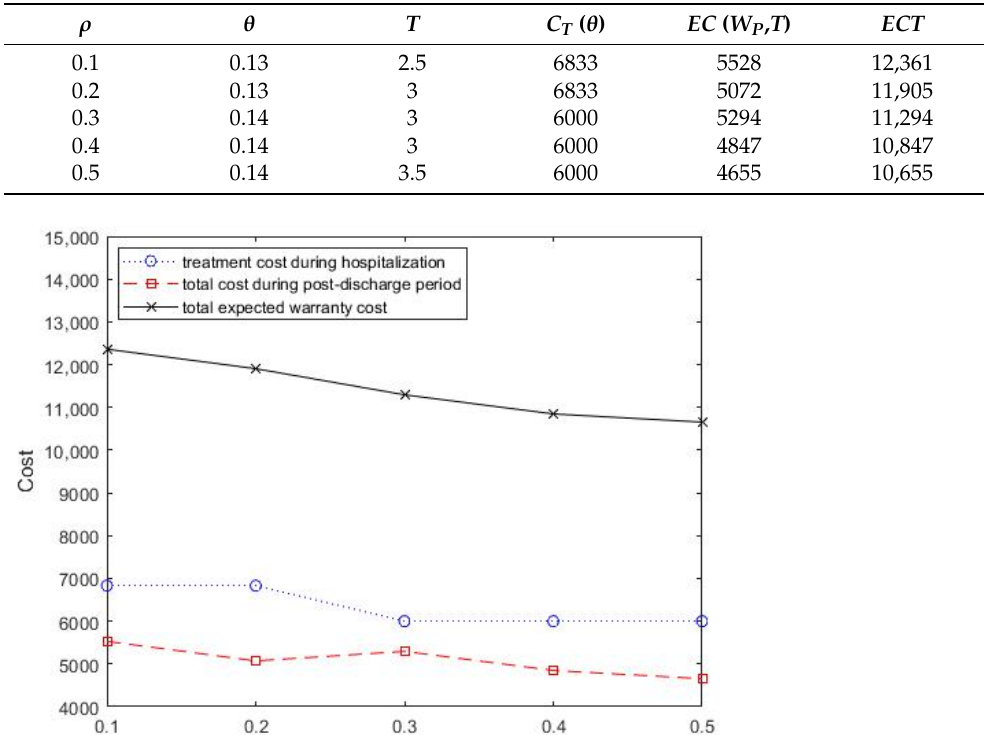
Table 5. Effect of improvement factor of drug intervention on the optimal treatment decision and monitoring strategy.